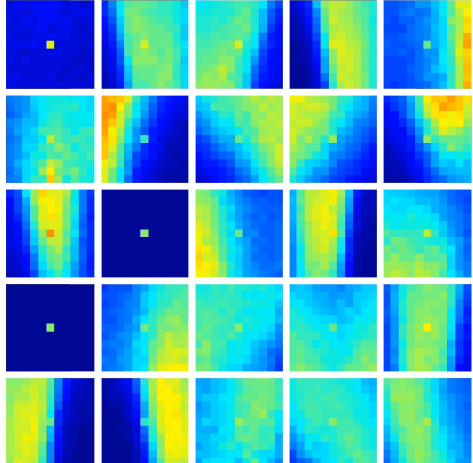
Figure 8. FEAST Features for the Plane Dropping dataset. The 25 spatiotemporal features produced when using the FEAST algorithm on the Plane Dropping dataset. Specific features can be seen coding for the leading edge of the airplane nosecone and for the wings. There are three features that code for noise events, as can be seen by the near-empty features. Table 2. Summary of classification accuracies on the Plane Dropping dataset. Four classifiers, a linear